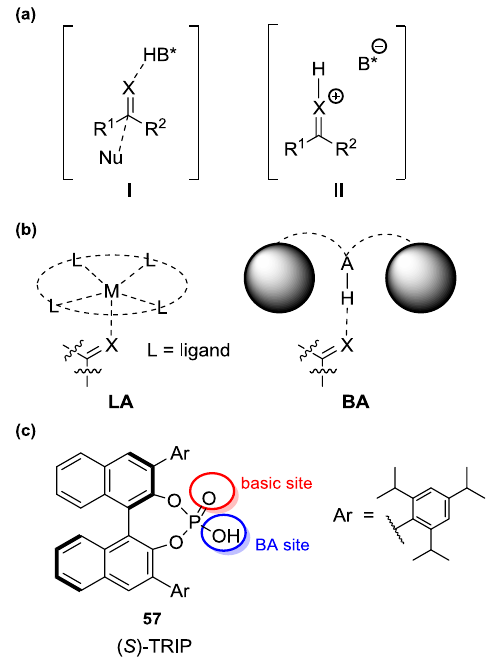
Figure 15. (a) Transition states in general acid catalysis (I) and in speci fi c acid catalysis (II); (b) Lewis acid (LA) and Brønsted acid (BA) catalysts; (c) ( S )-TRIP [( S )-3,3 ′ -bis(2,4,6-triisopropylphenyl)- 1,1 ′ -binaphthyl-2,2 ′ -diyl hydrogen